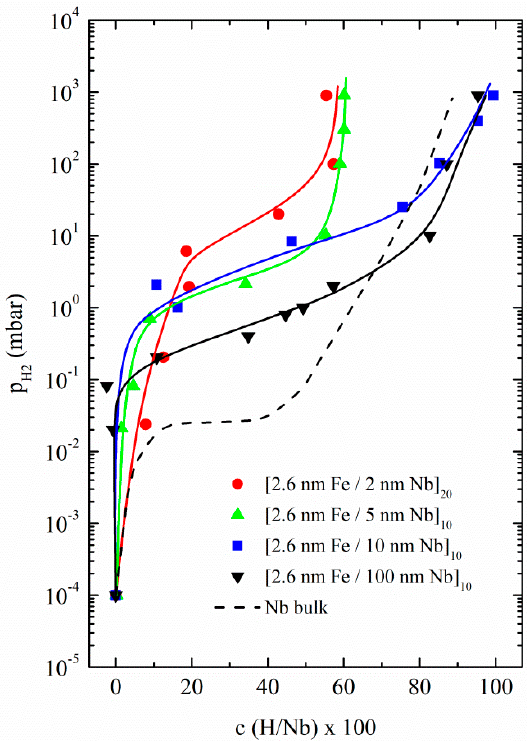
Figure 8. Phase diagram for hydrogen absorbing Nb thin films. Reprinted from [56] with permission from Elsevier.